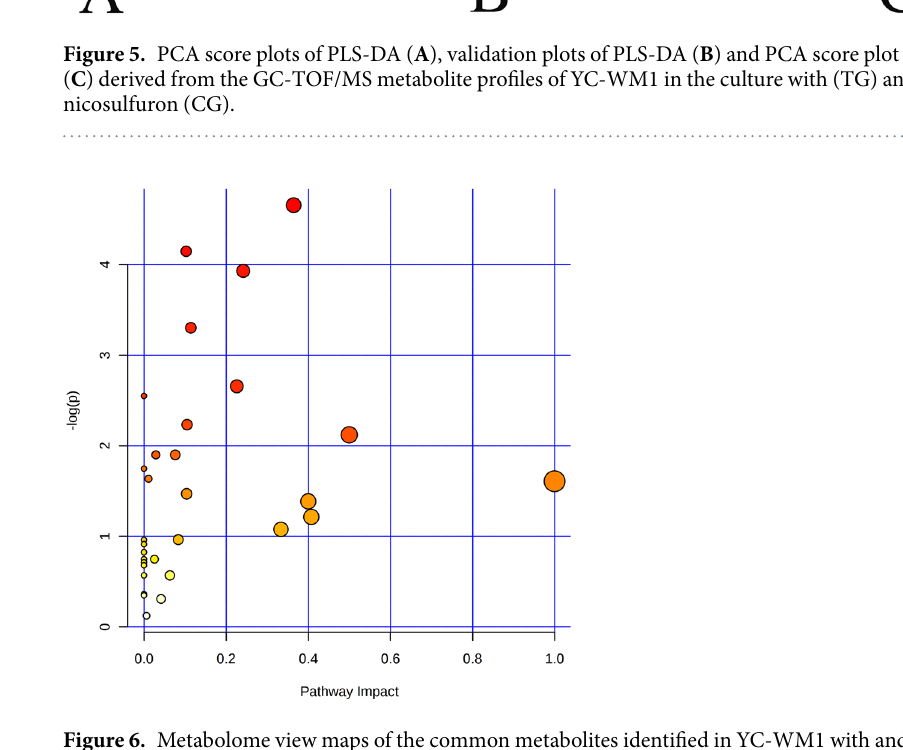
Figure 6. Metabolome view maps of the common metabolites identified in YC-WM1 with and without nicosulfuron. The x-axis represents the pathway impact, and y-axis represents the pathway enrichment. Larger sizes and darker colors represent higher pathway enrichment and higher pathway impact